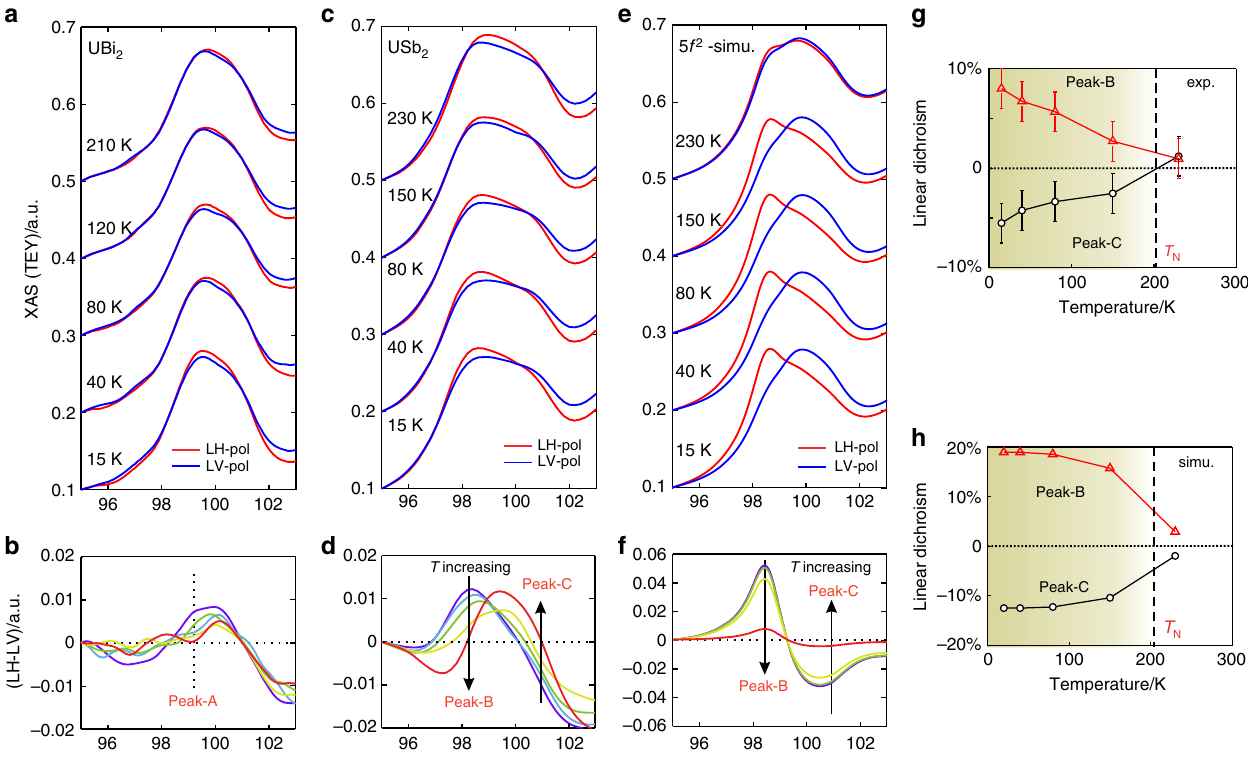
Fig. 3 Temperature dependence of occupied f-electron symmetries. a The R1 XAS spectrum of UBi 2 is shown for linear horizontal (LH) and vertical (LV) polarizations. b The dichroic difference (LH-LV) is shown with temperature distinguished by a rainbow color order (15K (purple), 40K (blue), 80K (green), 120K (yellow), and 210K (red)). c , d Analogous spectra are shown for USb 2 . Arrows in d show the monotonic trend direction on the peak-B and peak-C resonances as temperature increases. e , f Simulations for 5 f 2 with mean- fi eld magnetic interactions. g A summary of the linear dichroic difference on the primary XAS resonances of USb 2 , as a percentage of total XAS intensity at the indicated resonance energy ( h υ = 98.2 eV for peak-B, and h υ = 100.8 eV for peak-C). Error bars represent a rough upper bound on the error introduced by curve normalization. h The linear dichroic difference trends from the mean fi eld model. Source data are provided as a Source Data fi le. Shading in g , h indicates the onset of a magnetic ordered